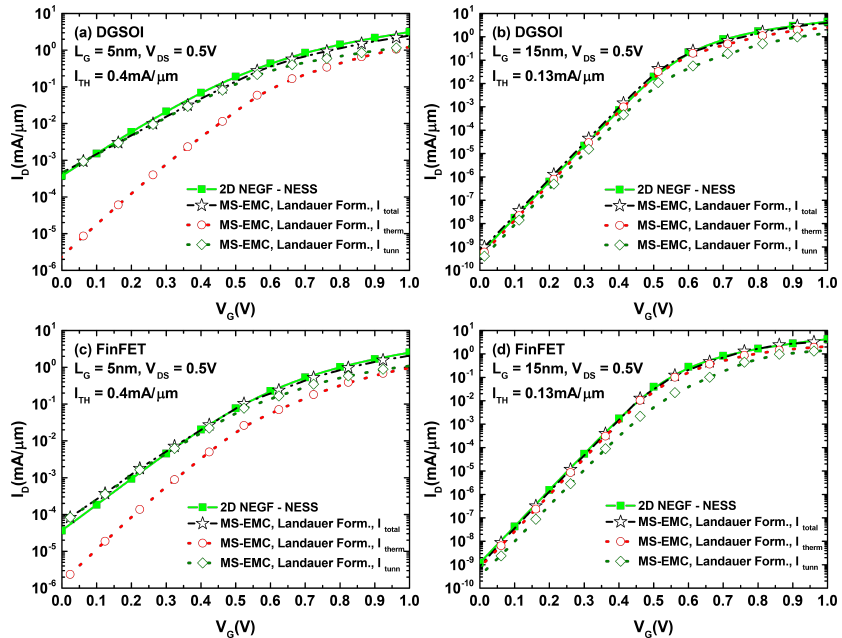
Figure 8. I D − V G characteristics for the DGSOI and FinFET with the shortest and longest gate lengths considered in our work, respectively: ( a ) DGSOI with L G = 5 nm, ( b ) DGSOI with L G = 15, nm, ( c ) FinFET with L G = 5 nm, and ( d ) FinFET with L G = 15 nm. The plots compare the results from NEGF with those from MS-EMC employing the Landauer approach for the current compu- tation. The total current reported from MS-EMC was also broken down into its tunneling and thermionic contributions.